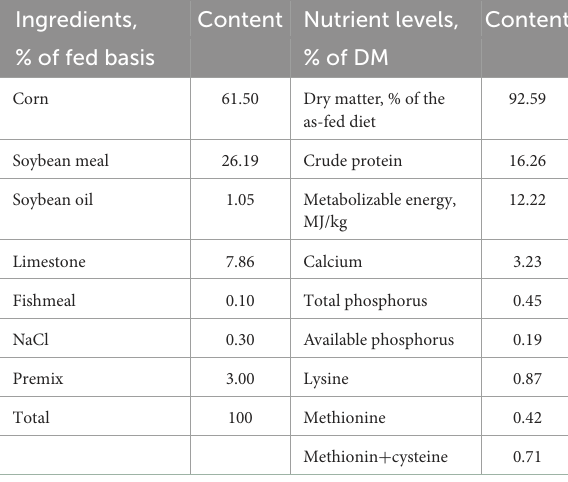
TABLE 1 The chemical composition and nutrient levels of basal diet.